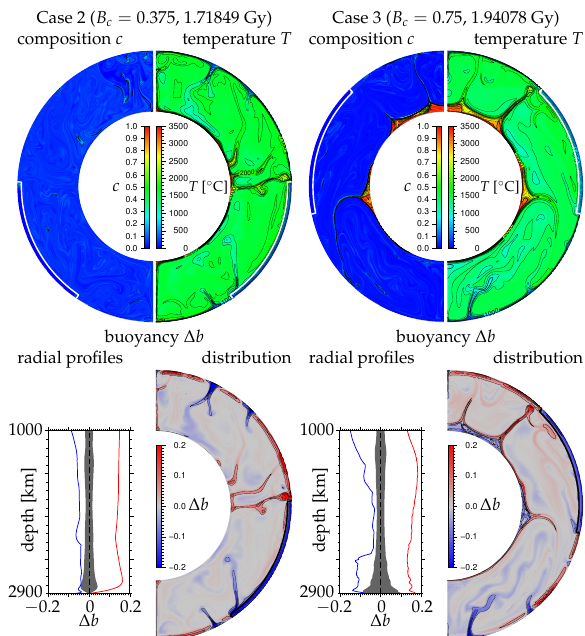
Figure 7. Comparison of the snapshots of the thermochemical states of Cases 2 and 3 at the elapsed times indicated in the figure. Shown by color and contour lines in the first row of each column are the distributions of fraction c of the dense component (top left) and temperature T (top right). The meanings of the colors and thick white lines are the same as in Figure 4. Shown in the second row of each column are the distributions of dimensionless buoyancy ∆ b coming from the differences in T and c at given depth (bottom right) and its radial profiles in the depth ranges below 1000 km from the top surface (bottom left). For the color scales for the distributions of ∆ b , see the scale bars in the figure. In the plots of the bottom left of each row, the red and blue lines indicate the maximum and minimum values of ∆ b at given depth, respectively, while the shaded regions delineate the standard deviation of ∆ b at the depth.